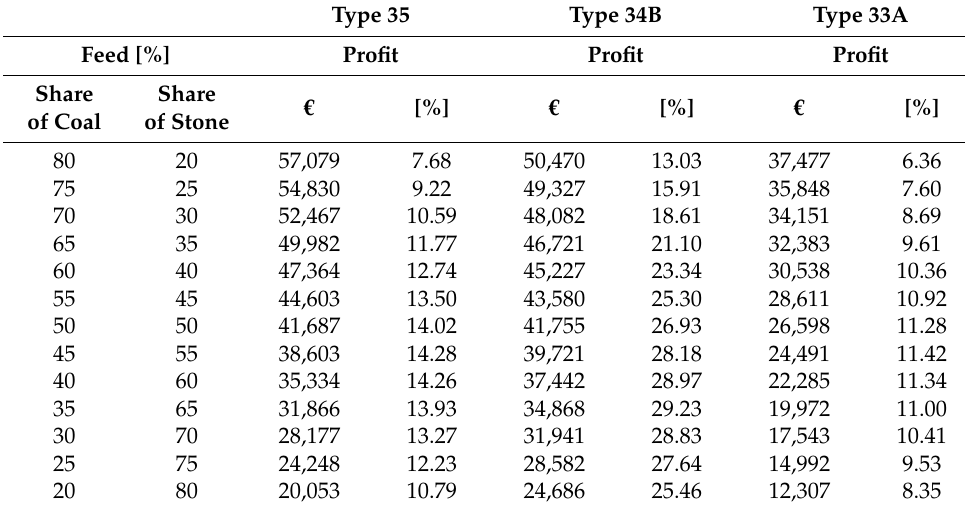
Table 6. Hourly profit from the selective crushing process—capacity 500